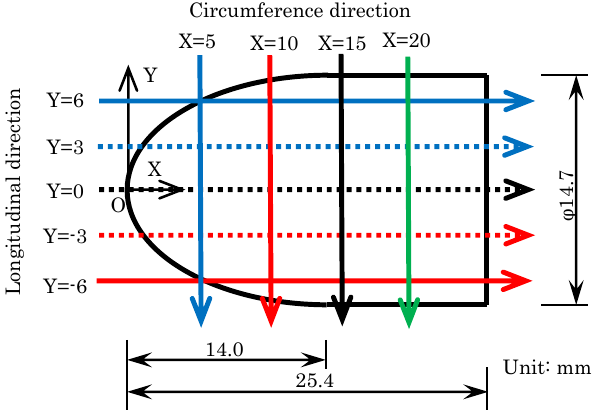
Figure 7. Position of the luminescence ratio profile extraction.